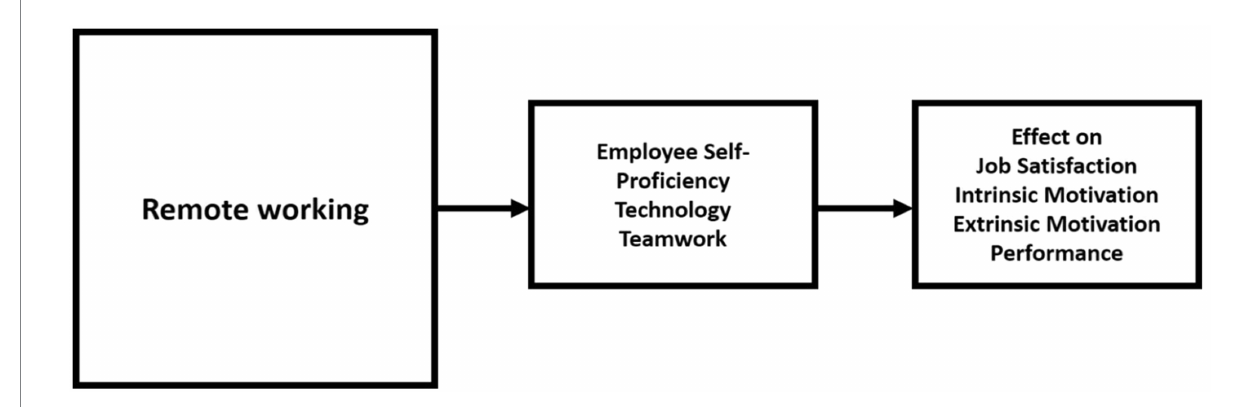
FIGURE 1 Theoretical framework-Remote work and job satisfaction, intrinsic and extrinsic motivation and performance.